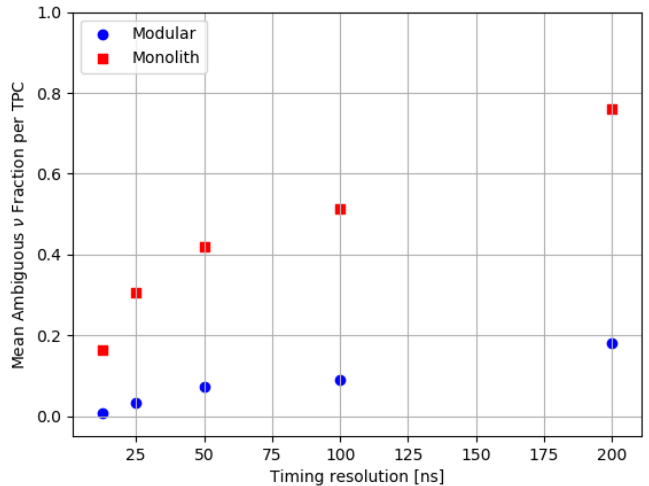
FIG. 4: Number of neutrino interactions producing visible signals per TPC drift region as a function of visible energy threshold, where the solid line is the Figure 38. Assuming removal of late scintillation light from the prompt component, the “ambiguous FIG. 5: Assuming removal of late scintillation light ν fraction” reflects the fraction of neutrino interactions per TPC drift region that cannot be resolved for a given timing from the prompt component, the "ambiguous ⌫ fraction" reflects the fraction of ⌫ interactions per TPC drift region that cannot be resolved by the prescribed timing resolution.